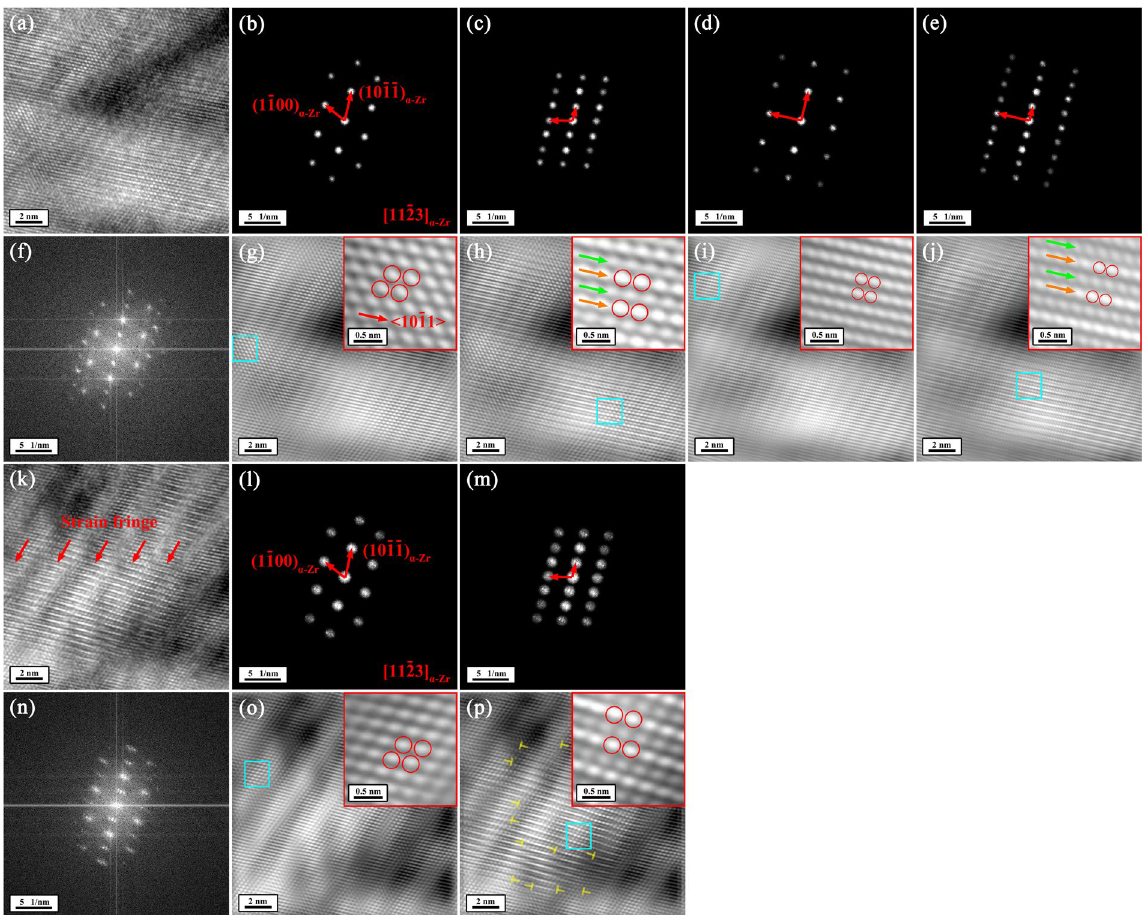
Figure 5. Changes of atomic structure within the α -Zr matrix after irradiation at room temperature with focused and stationary electron beam at an incident energy of 30 keV in the FE-SEM viewed along the [11 ̄ 2 3] α - α -Zr matrix containing electron-beam- Zr direction. ( a ) and ( k ) HRTEM images of two typical areas of the induced changes of atomic structure. ( f ) and ( n ) The FFT diffraction patterns corresponding to Fig. 5a and k, respectively. ( b , c , d and e ) The partially masked FFT diffraction patterns corresponding to Fig. 5f. ( g , h , i and j ) The noise-filtered IFFT images corresponding to Fig. 5a obtained by using the partially masked FFT diffraction patterns in Fig. 5b,c,d and e, respectively. The insets in Fig. 5g,h,i and j show the expanded morphologies of the areas outlined by blue squares in Fig. 5g,h,i and j, respectively. ( l ) and ( m ) The partially masked FFT diffraction patterns corresponding to Fig. 5n. ( o ) and ( p ) The noise-filtered IFFT images corresponding to Fig. 5k obtained by using the partially masked FFT diffraction patterns in Fig. 5l and m, respectively. The insets in Fig. 5o and p show the expanded morphologies of the areas outlined by blue squares in Fig. 5o and p, respectively. The yellow ‘T's in Fig. 5p indicate the electron-beam-induced